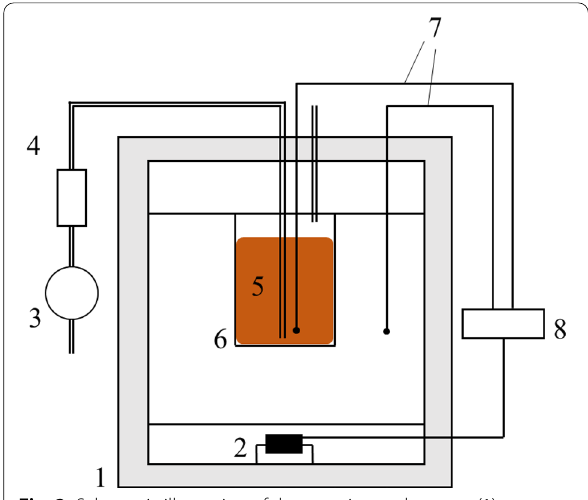
Fig. 2 Schematic illustration of the experimental system. (1) Thermostat, (2) heater, (3) air compressor, (4) air flow meter, (5) material, (6) reactor, (7) thermocouple, (8) data